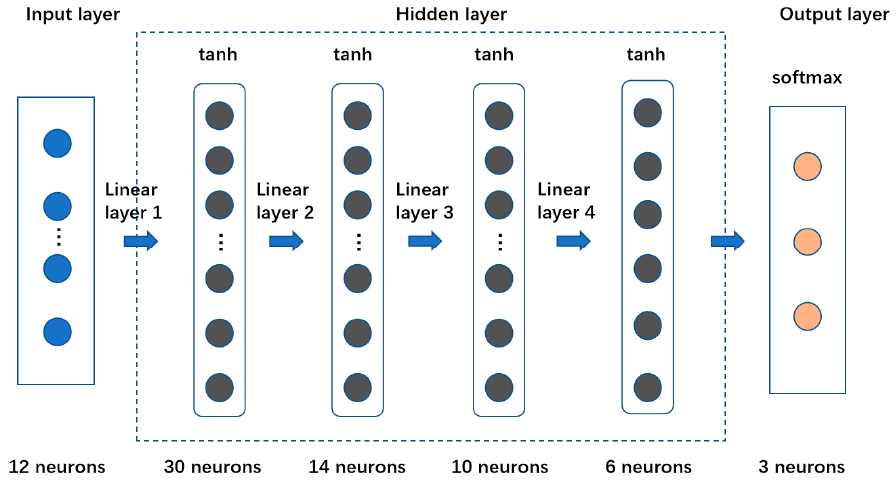
Figure 10. Tanh4-BP network architecture.